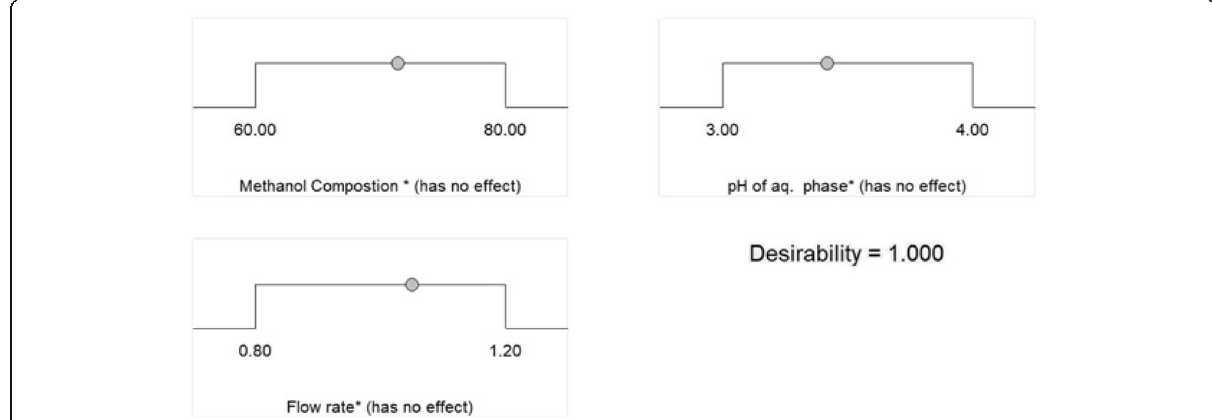
Fig. 3 Numerical optimization for chromatographic